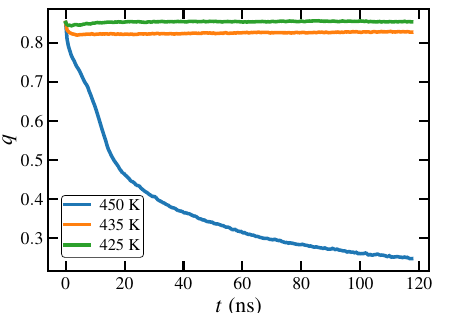
Figure 9. Transient order parameter q vs. time, t , after cessation of steady-state UEF at De = 30.0 of the PE melt at 450 K with and without simultaneous quenching to a lower temperature, as labelled in the